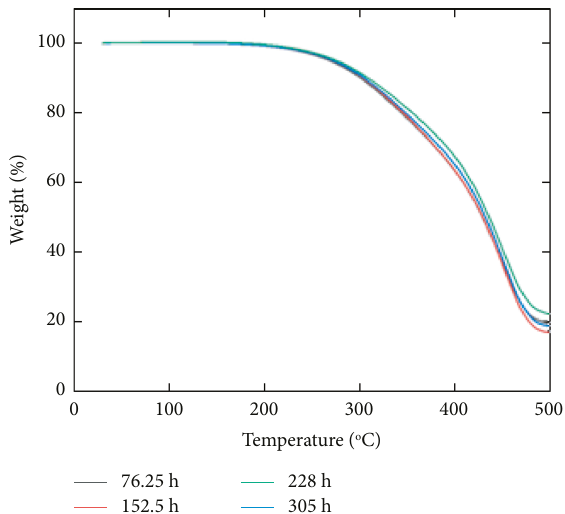
Figure 11: TG test results of ASA-modified asphalt under different UV aging times.